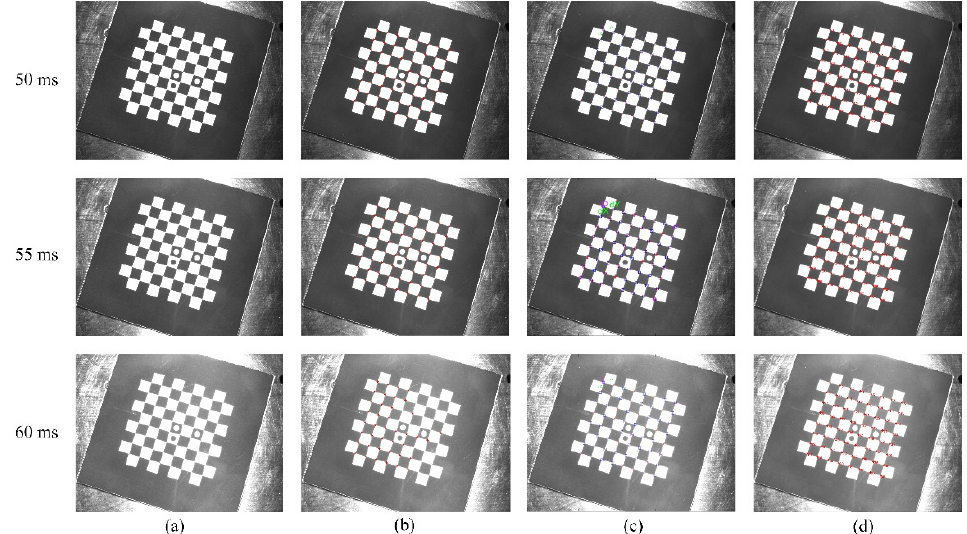
Figure 8. Comparison of corner-detection results in overexposure state: ( a ) original image, ( b ) corner-detection result of the literature [36] method, ( c ) corner-detection result of MATLAB Toolbox, and ( d ) corner-detection result of the method in this paper. Table 1. Comparison of the number of corners detected by the three methods.